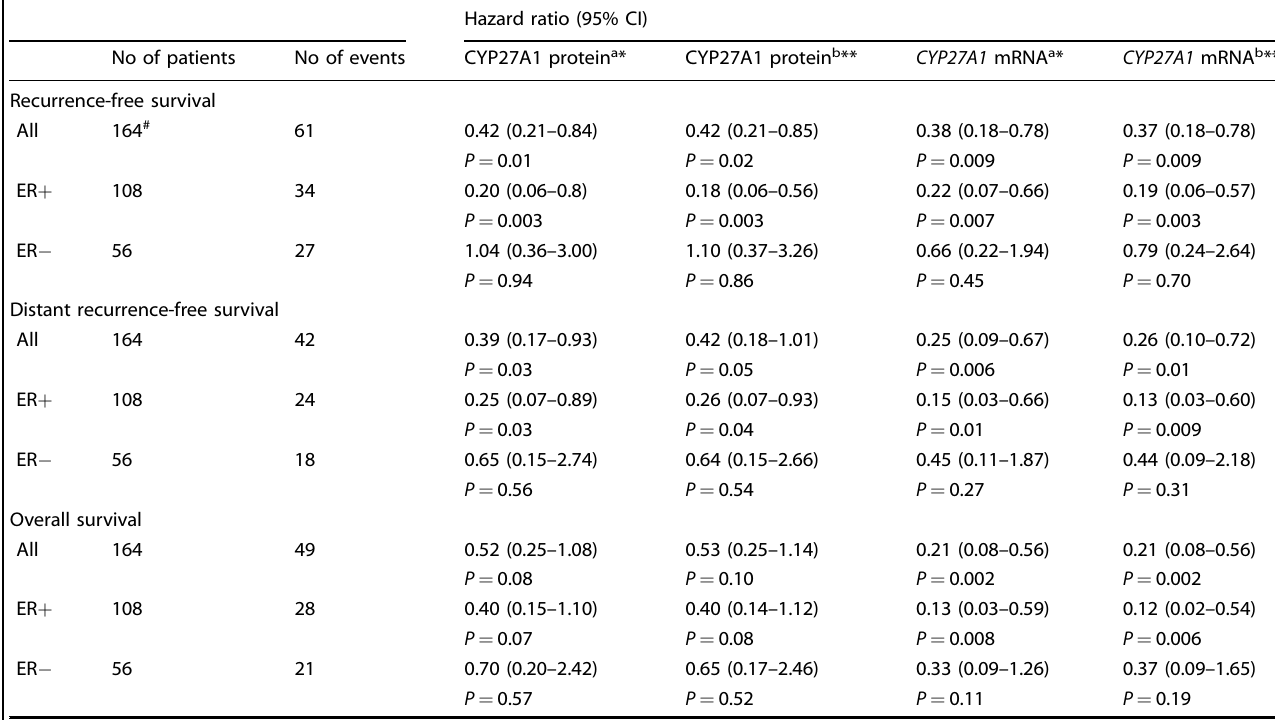
Table 2. Multivariable-adjusted hazard ratios (95% CI) for all evaluated endpoints by tumor CYP27A1 expression. Hazard ratio (95% CI) No of